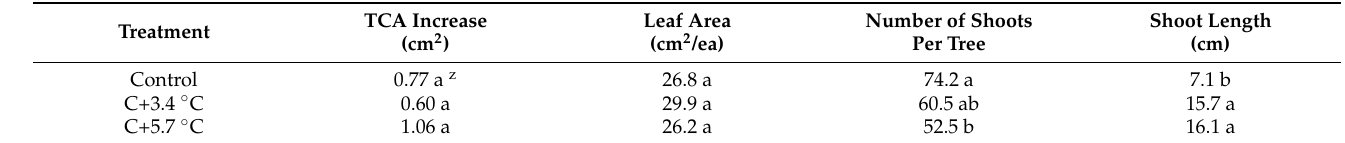
Table 3. Growth characteristics of ‘Mihong’ peaches as affected by elevated temperatures under a carbon dioxide concentration of 700 µ mol · mol − 1